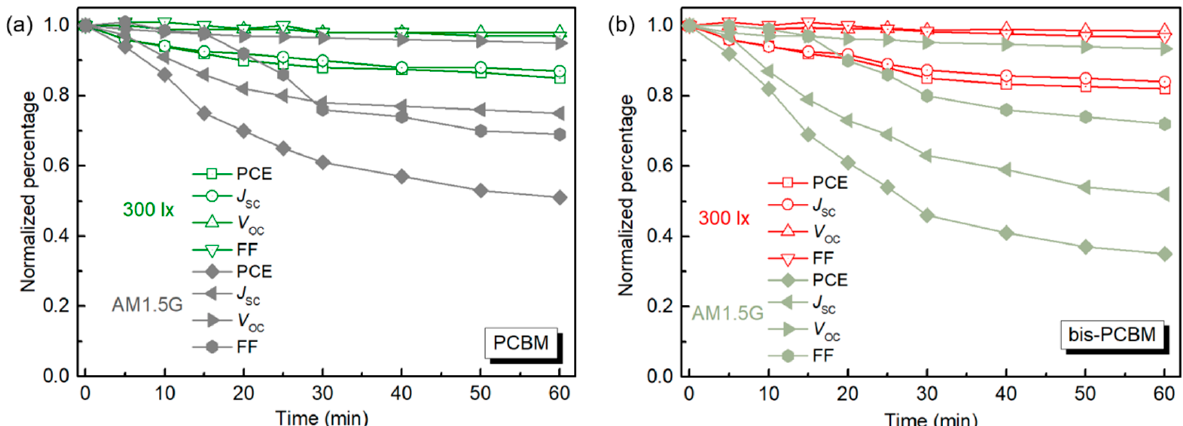
Figure 3. The normalized device performance parameters of the OPV devices based on PCDTBT blended with PCBM ( a ) and bis-PCBM ( b ) after degradation under AM 1.5G or 300 lx indoor light, in air, for a different time. All performance parameters are normalized to the value measured for the undegraded device.